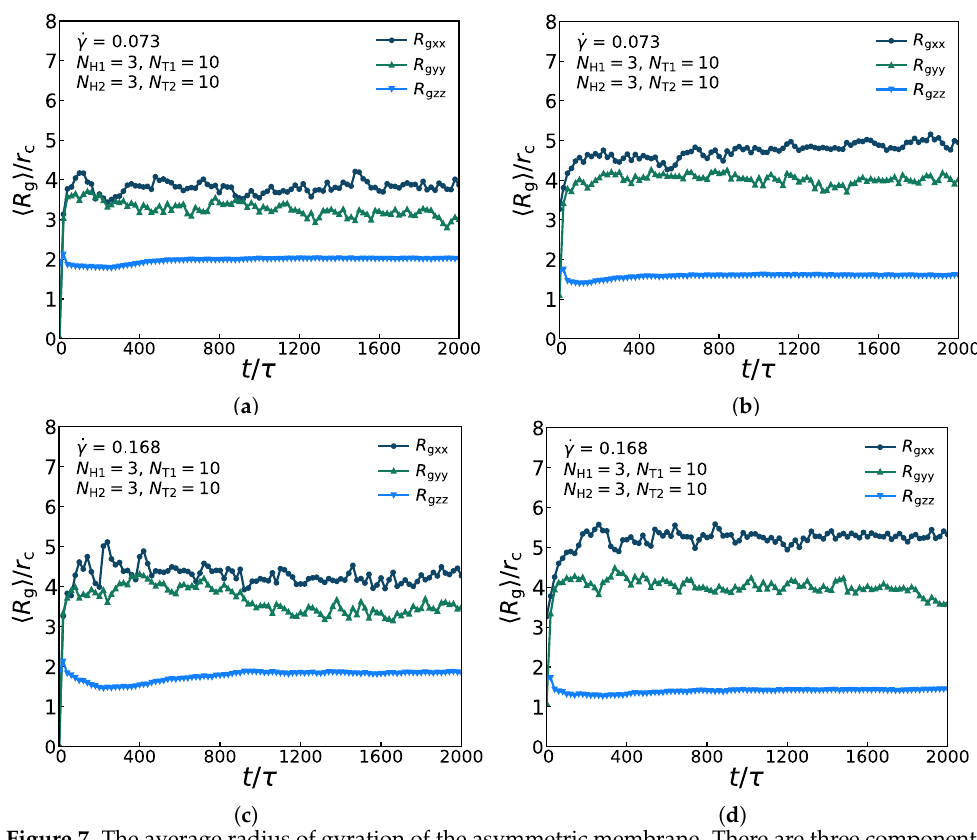
Figure 7. The average radius of gyration of the asymmetric membrane. There are three components R gxx , R gyy , R gzz of R g at two different shear rates ˙ γ = 0.073 and ˙ γ = 0.168 as functions of time steps for ( a , c ) the first type of lipid chains, and ( b , d ) the second type of lipid chains.